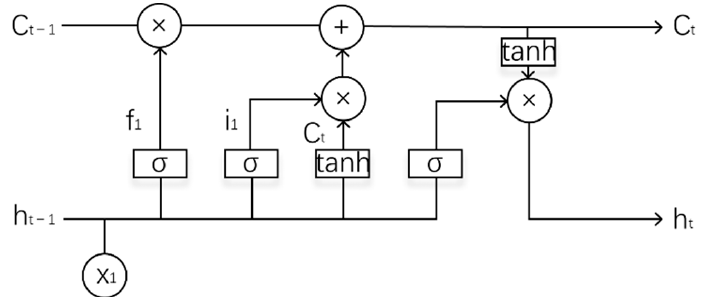
Figure 4. The LSTM structure.